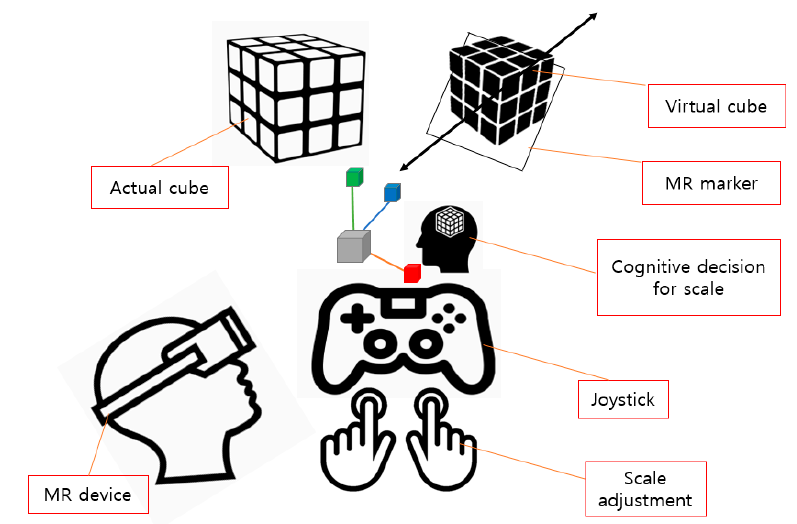
Figure 7. Experimental task of adjusting the scale parameter of the virtual cube in comparison with the actual cube. In the experiment, the subject was asked to match the size of the actual cube. In the first frame, the virtual cube was presented as large. Participants were able to adjust the size with a joystick.